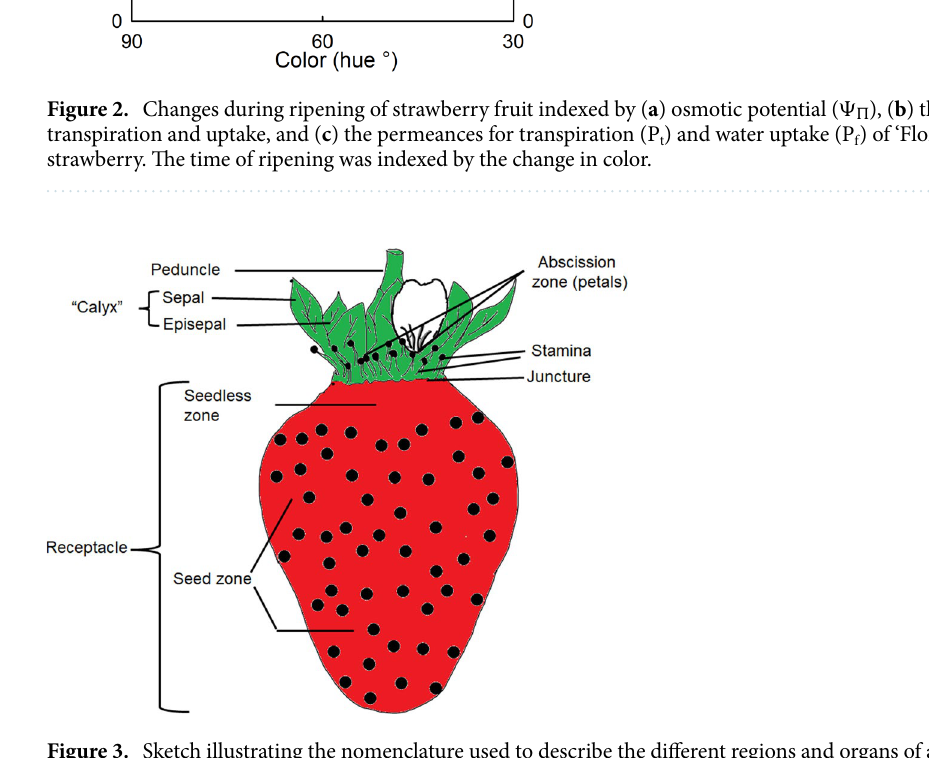
Figure 3. Sketch illustrating the nomenclature used to describe the different regions and organs of a strawberry fruit addressed by the sealing treatments. We refer to the portion of the receptacle that lacks seeds (strictly, the zone lacking the single-seeded achenes) as the ‘seedless’